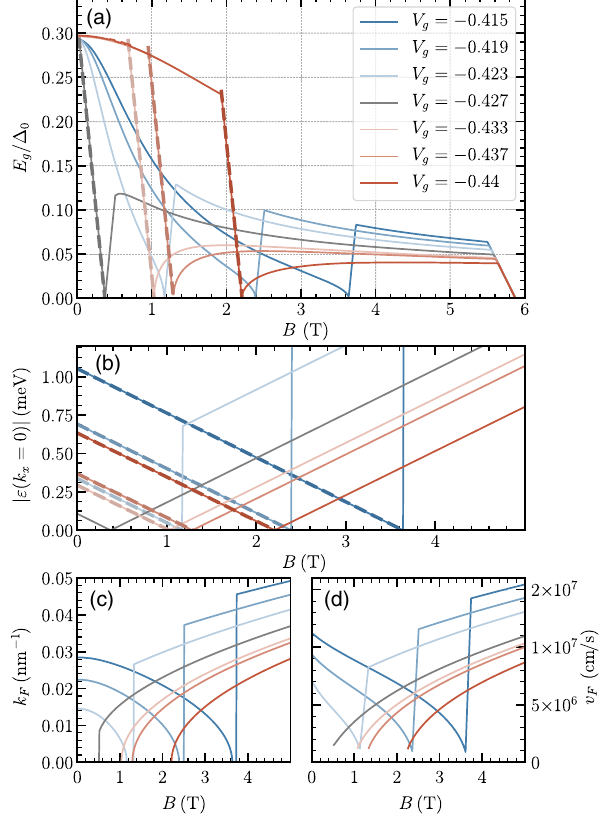
FIG. 9. The evolution of the system parameters as a function of a magnetic field B . Estimates for the (a) gap, (b) absolute value of the effective Fermi level of the subband j ε ð k 0 is the location of the band bottom), (c) Fermi momentum, k x ¼ and (d) Fermi velocity as a function of magnetic field. Colors correspond to different gate voltages: for blue lines, the gate voltage is more positive, leading to a situation as sketched in Figs. 8(a) and 8(b). Red lines, on the other hand, have a more strongly negative gate voltage, thus leading to the situation of Figs. 8(c) and 8(d). Gray color corresponds to the threshold value − 0 . 427 V, at which the subband is characterized by a V g ¼ vanishing effective chemical